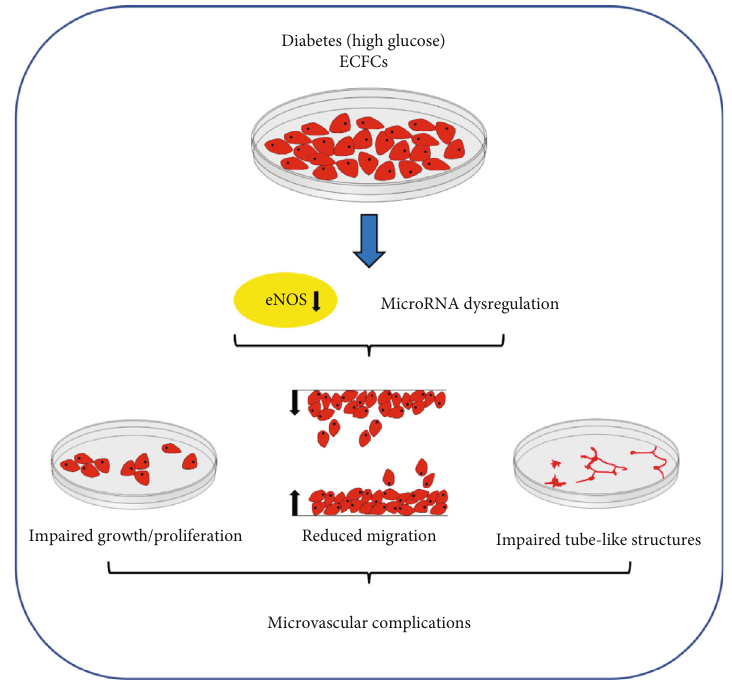
Figure 3: Mechanisms of ECFC dysfunction in the presence of high levels of